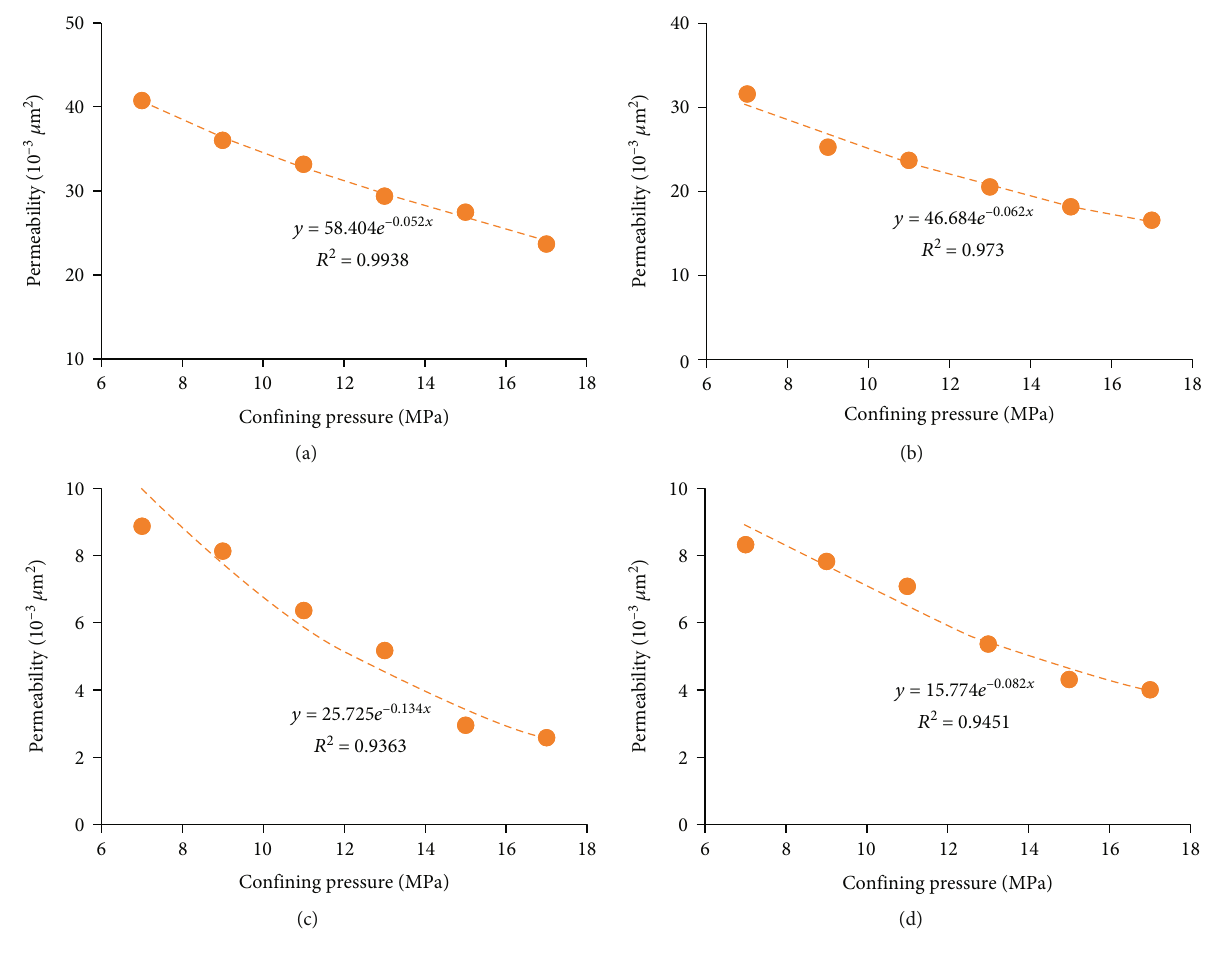
Figure 8: Permeability in fl uenced by the con fi ning